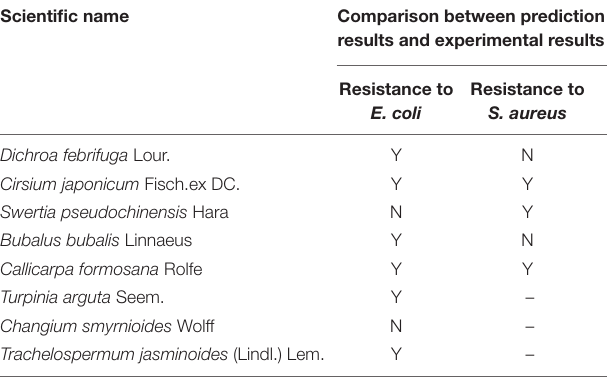
TABLE 4 | Comparison between models’ prediction results and experimental results.